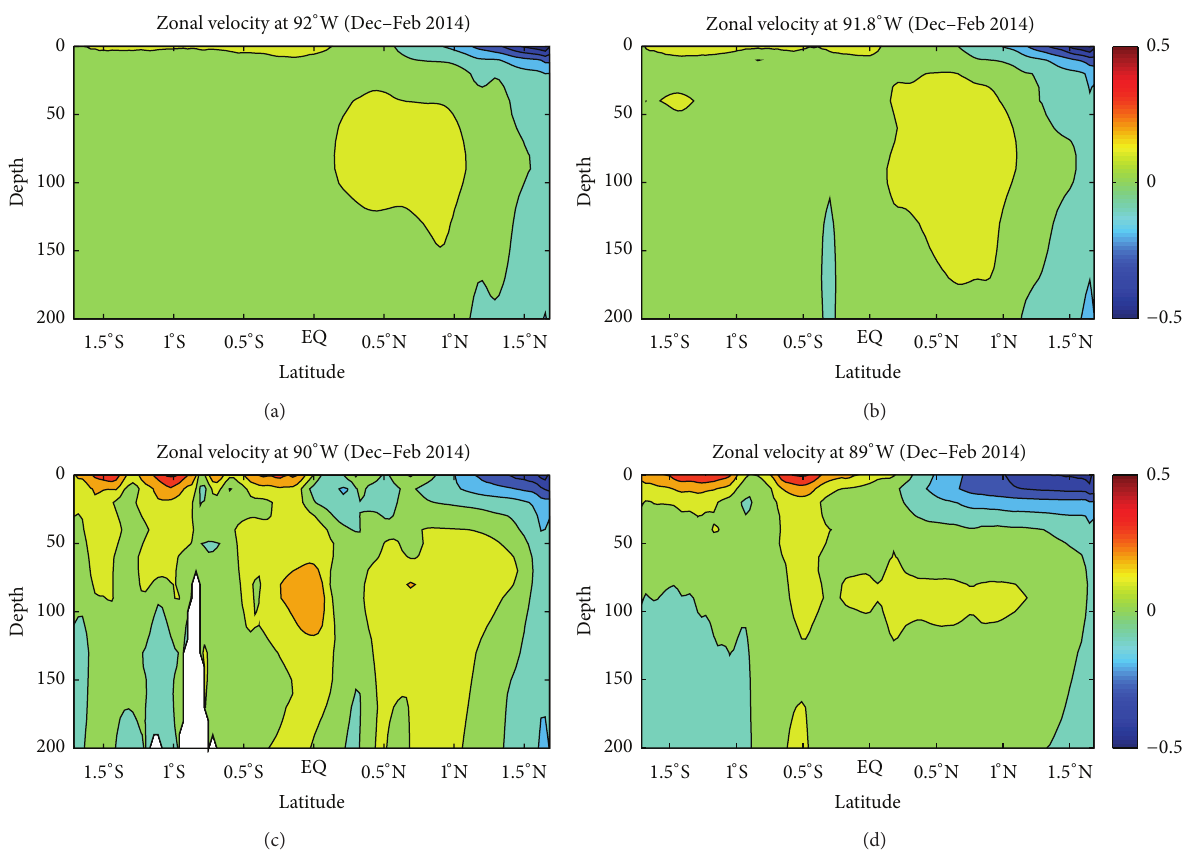
Figure 15: Vertical sections of zonal current (ms −1 ) along 92 ∘ W, 91.8 ∘ W, 90 ∘ W, and 89 ∘ W for the upper 200 m around the GMR in Dec–Feb 2014 El Ni˜no